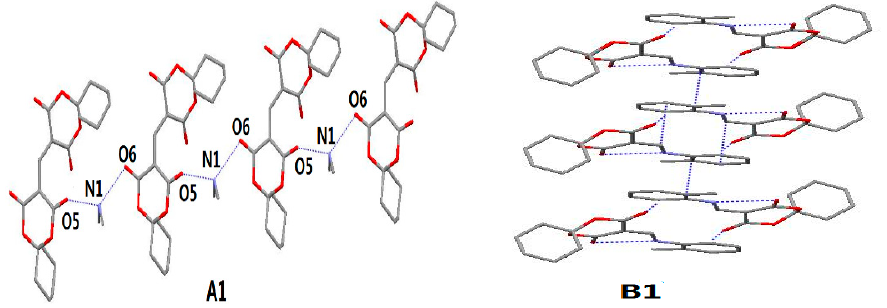
Figure 2. 1D-chained structure of A1 and 3D-network structure of B1 . Table 2. Selected bond distances (A°) and angles (deg) of A1 and B1 .